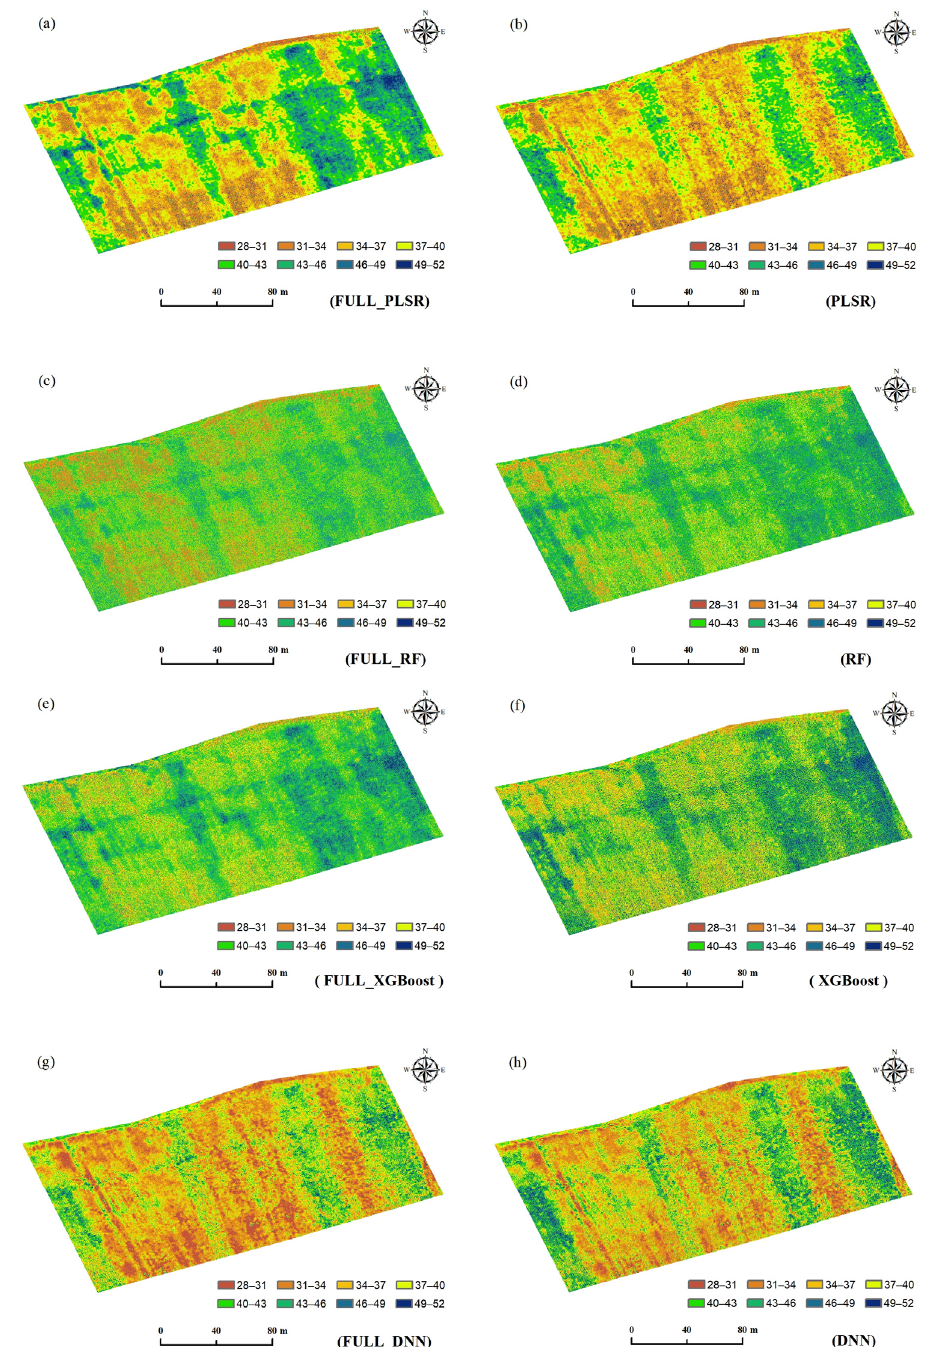
Figure 14. Inversion diagram of SPAD values: ( a ) the PLSR model based on the full-wave spectral in the SSR, ( b ) the PLSR model based on the characteristic band selected by CARS_SPA in the SSR, ( c ) the RF model based on the full-wave spectral in the SSR, ( d ) the RF model based on the characteristic band selected by CARS_SPA in the SSR, ( e ) the XGBoost model based on the full-wave spectral in the SSR, ( f ) the XGBoost model based on the characteristic band selected by CARS_SPA in the SSR, ( g ) the DNN model based on the full-wave spectral in the SSR, ( h ) the DNN model based on the characteristic band selected by CARS_SPA in the SSR.